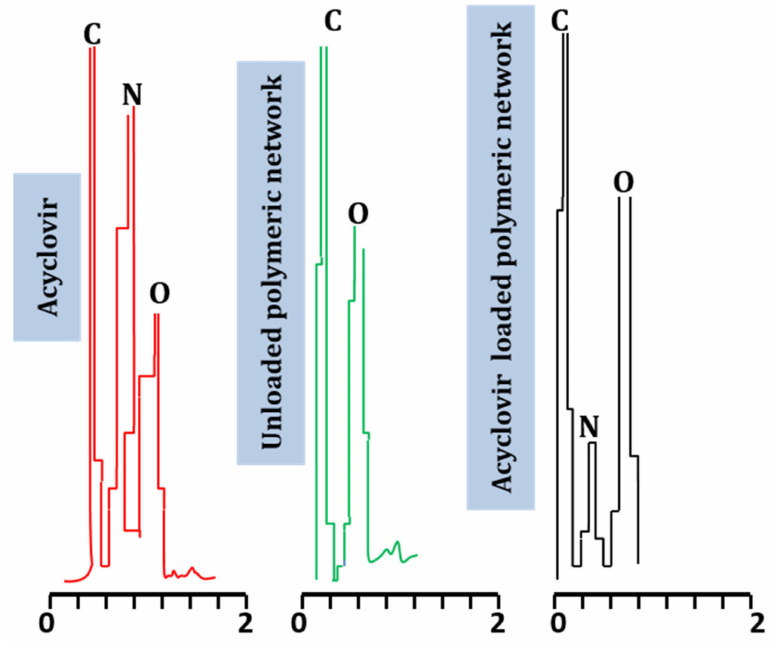
Figure 6. EDX spectra of